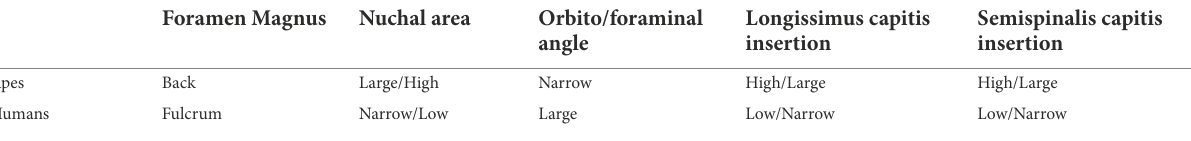
TABLE 1 Some distinctive anatomical features of the skull in apes and humans to be considered in the process of evolution to